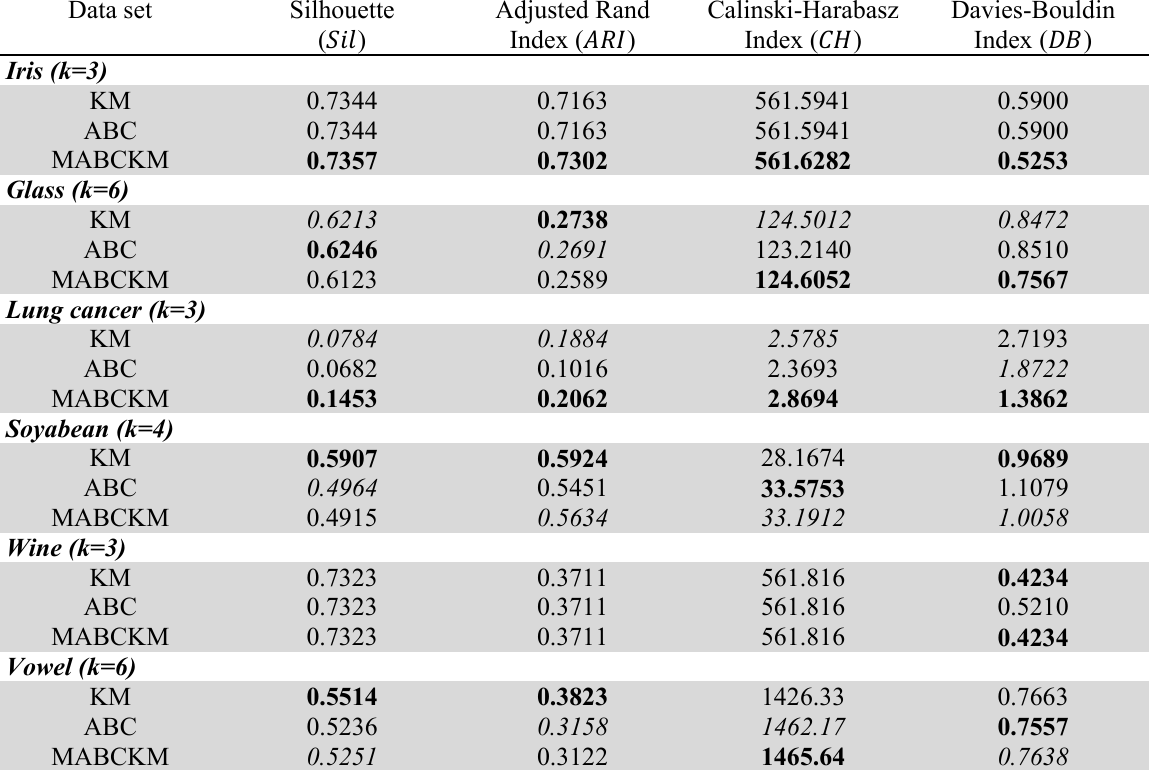
Results obtained by various algorithms for different data sets. Bold face indicates the best and italic face the second best